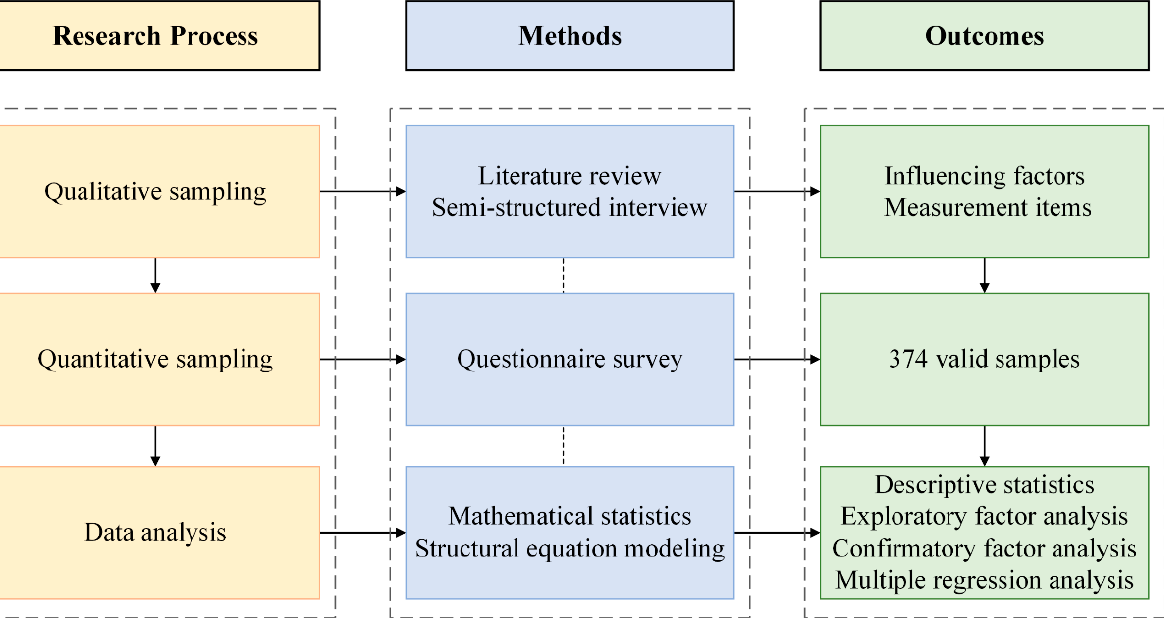
Figure 2. The research process of the study.